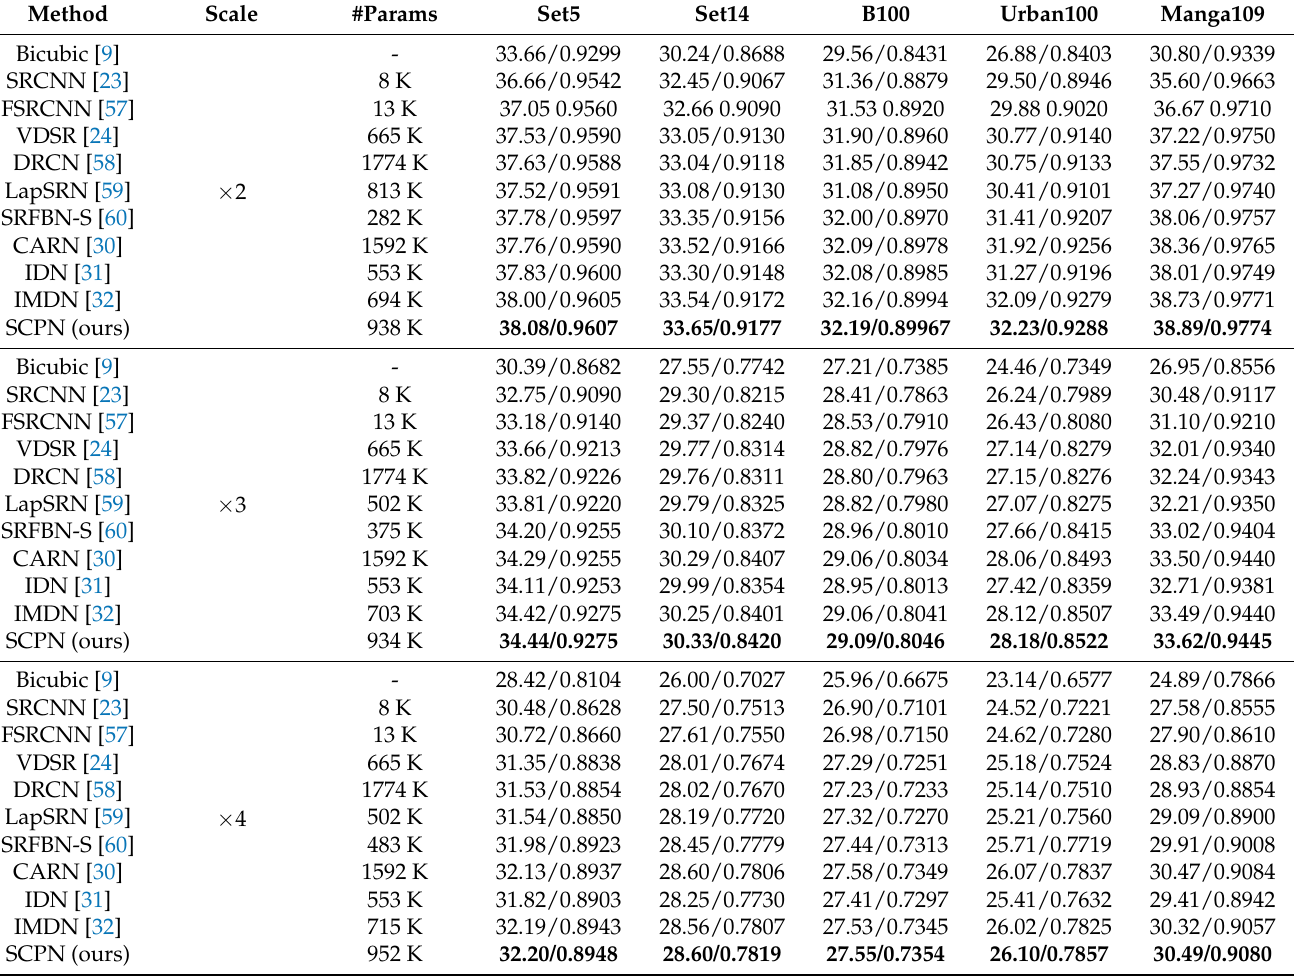
Table 2. Quantitative results of the compared methods in the format of PSNR/SSIM. #Params denotes parameters for short. The results are either reproduced by ourselves with the official settings or copied directly from the origin paper. Bold numbers indicate the best